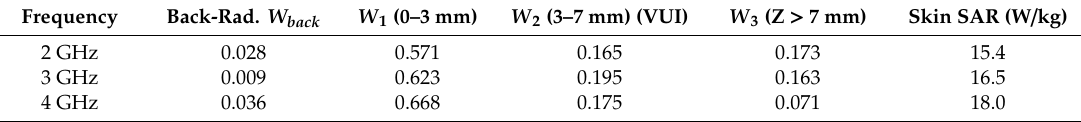
Table 3. Calculated weighting functions and SAR for the skin, for a power of 15